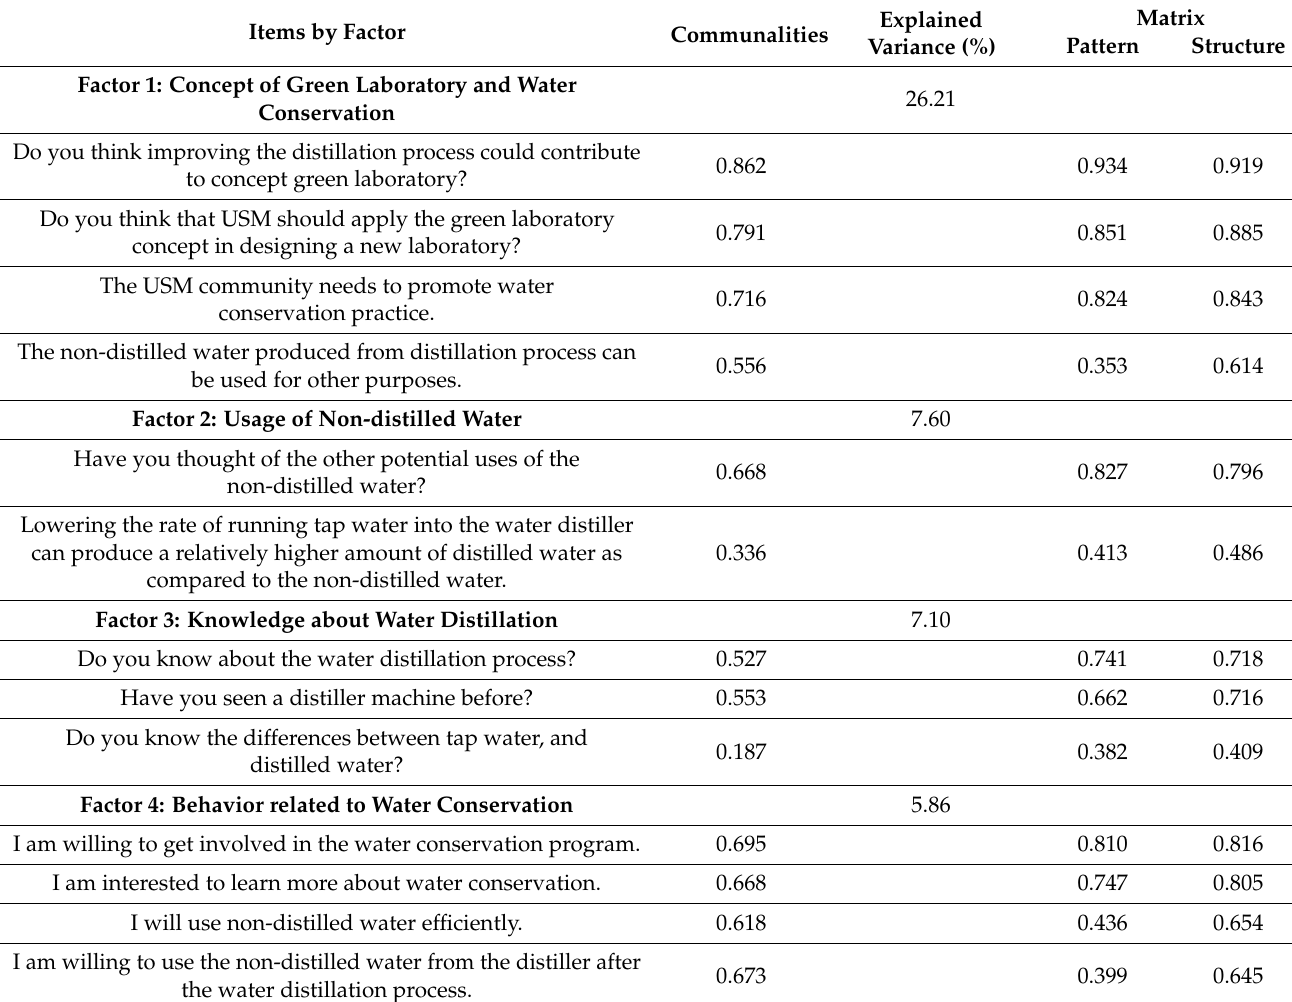
Table 3. Pattern and structure matrixes with communalities and explained variance of the extracted factors. Items by Factor Communalities